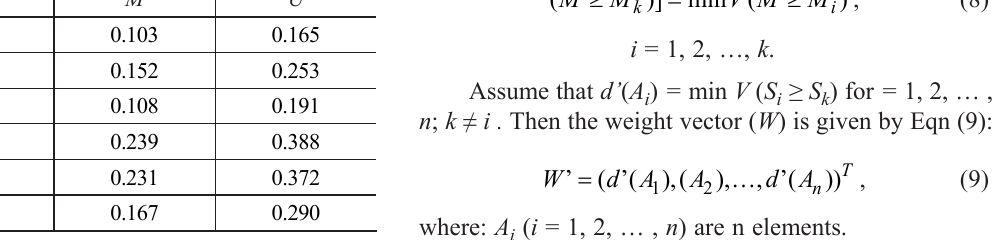
Table 4. The value of fuzzy synthetic extent for the pairwise comparisons of criteria with related to goal L M S 1